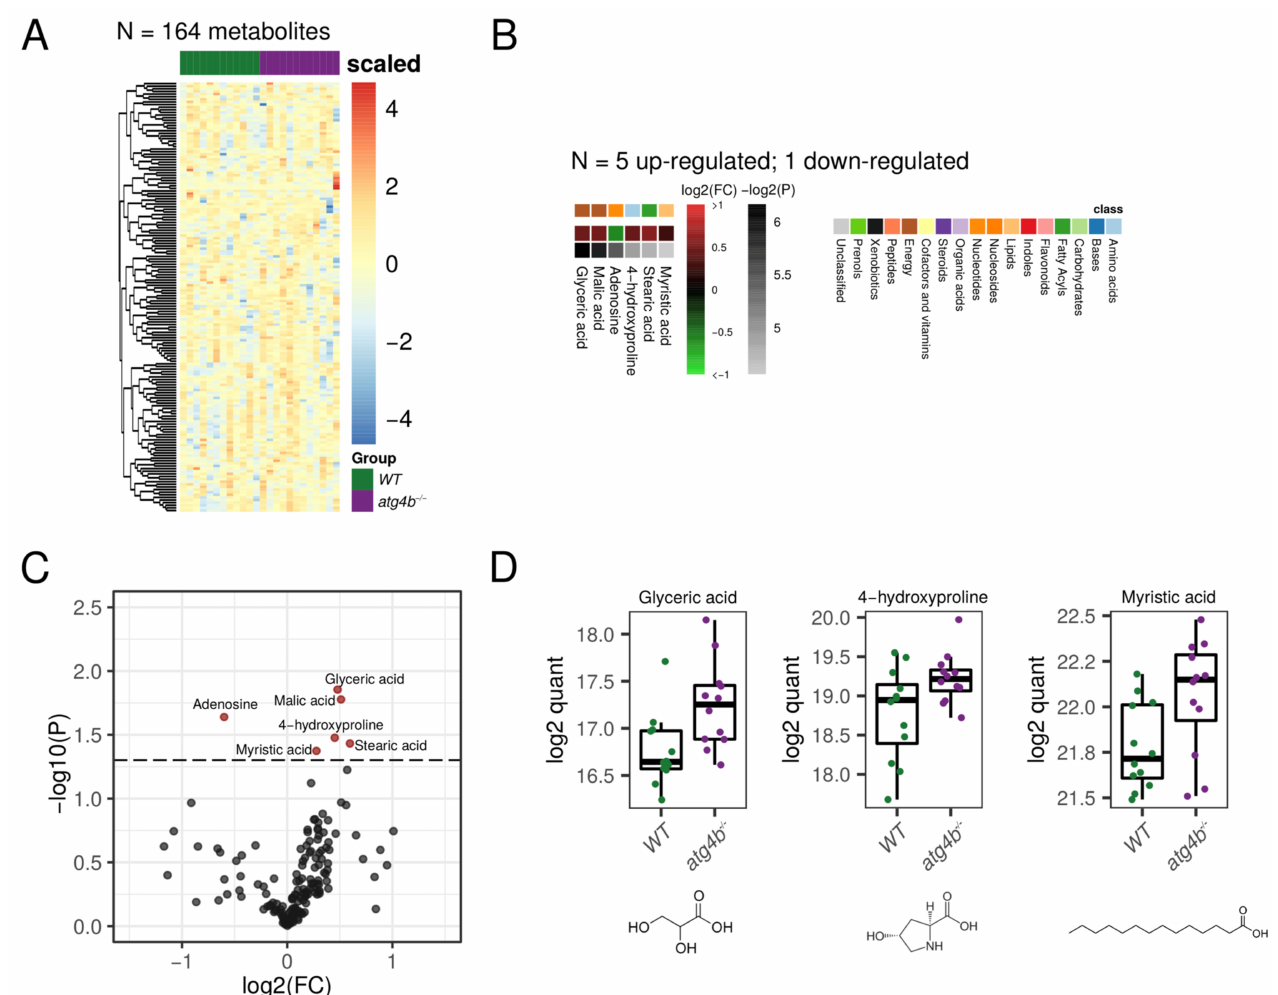
Figure 4. Autophagy deficiency upon ATG4B loss in liver. ( A ) Heatmap showing the row-scaled log2 quantification levels of all the profiled metabolites in liver tissue samples. ( B ) Heatmap describing the change (log2 of fold change) of the metabolites with significantly altered levels between WT and atg4b − / − samples. ( C ) Volcano plot comparing the effect size (log2 of fold change) to the significance ( − log10 of p -value) of the metabolites altered between WT and atg4b − / − samples. Significant metabolites are colored in red. Representative metabolites are labeled within the plot. ( D ) Boxplots showing the log2 quantification levels of three representative metabolites, which are significantly altered between WT and atg4b − / − samples. Significance is defined as an unadjusted p -value <